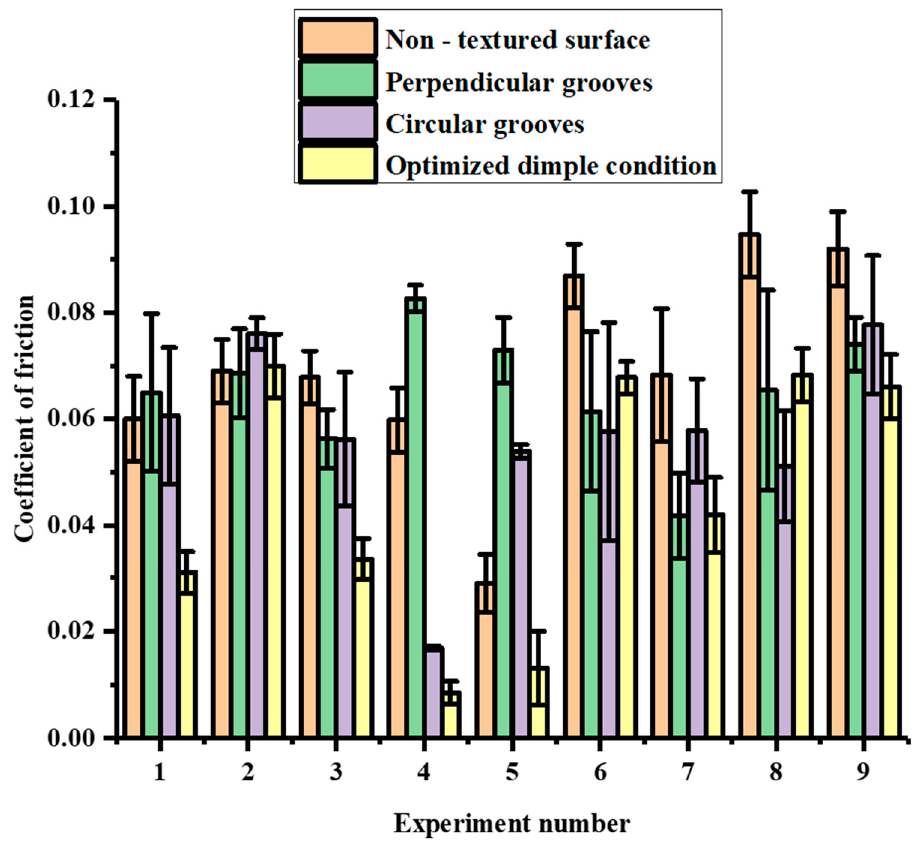
Figure 9. Comparison of the COF values as determined by different types of textures, along with the non-textured surface.